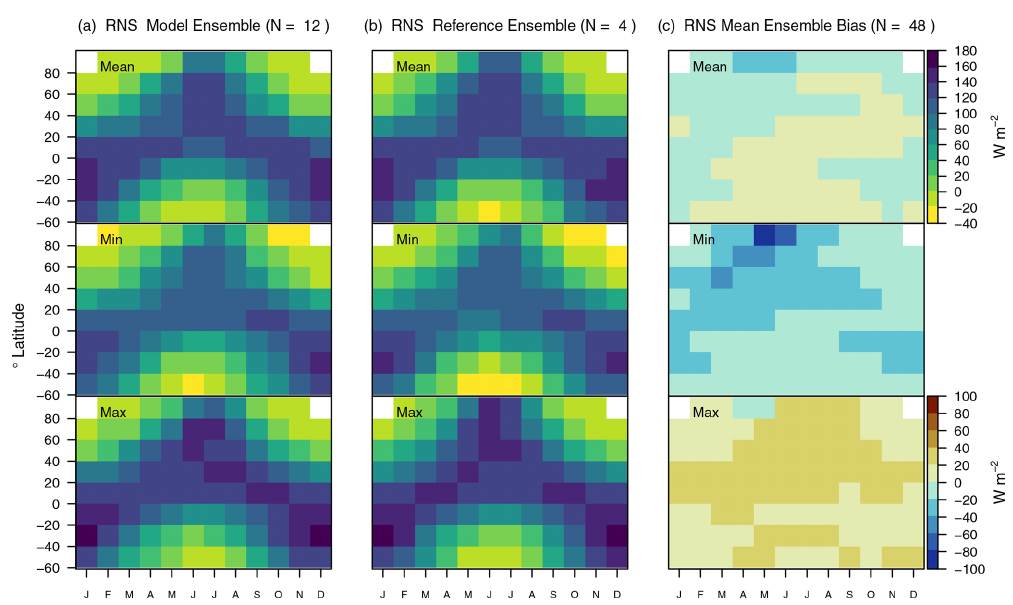
Figure 8. Net surface radiation computed from three model runs (CLASSIC driven with CRUJRAv2, GSWP3W5E5, and CRUNCEP) and four reference data sets (CERES, CLASSr, FluxCom, and GEWEXSRB). The top, center, and bottom rows provide ensemble mean, minimum, and maximum values for (a) CLASSIC, (b) reference data, and (c) corresponding biases. The mean, minimum, and maximum ensemble biases refer to the mean, minimum, and maximum values across all evaluations, respectively. For instance, a minimum bias that is negative implies that at least one evaluation yields a negative